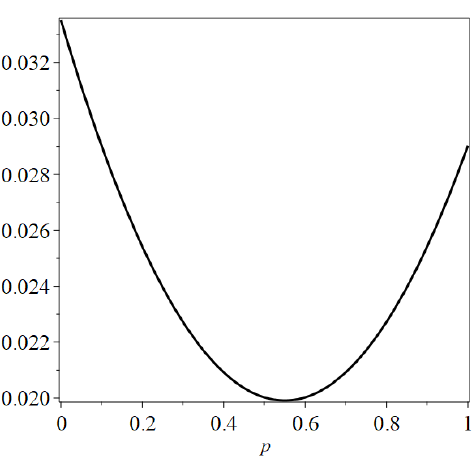
Figure 5. Numerical simulation of the profit difference between the hybrid platform mode and the platform mode.